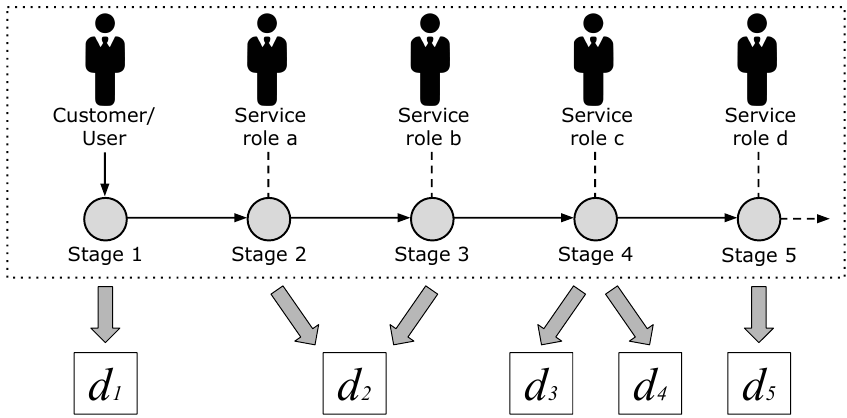
Figure 1. The dashed box shows the Service Journey Map model of [24]. Gray circles represent service stages; below each stage, we report the corresponding evaluation dimensions ( d 1 , ..., d 5 ). We downloaded the icons from